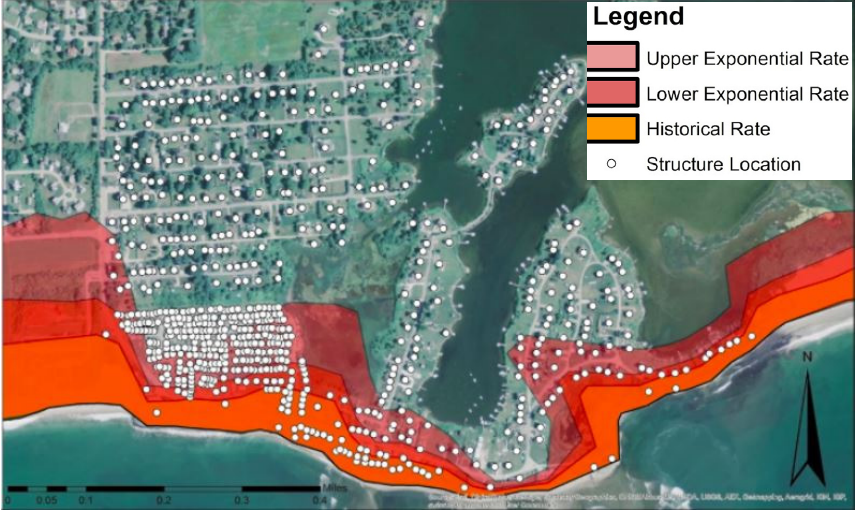
Figure 10. Estimated positions of the shoreline in the study area after 100 years using the historical erosion rate and two exponentially increasing erosion rates. erosion rate and two exponentially increasing erosion